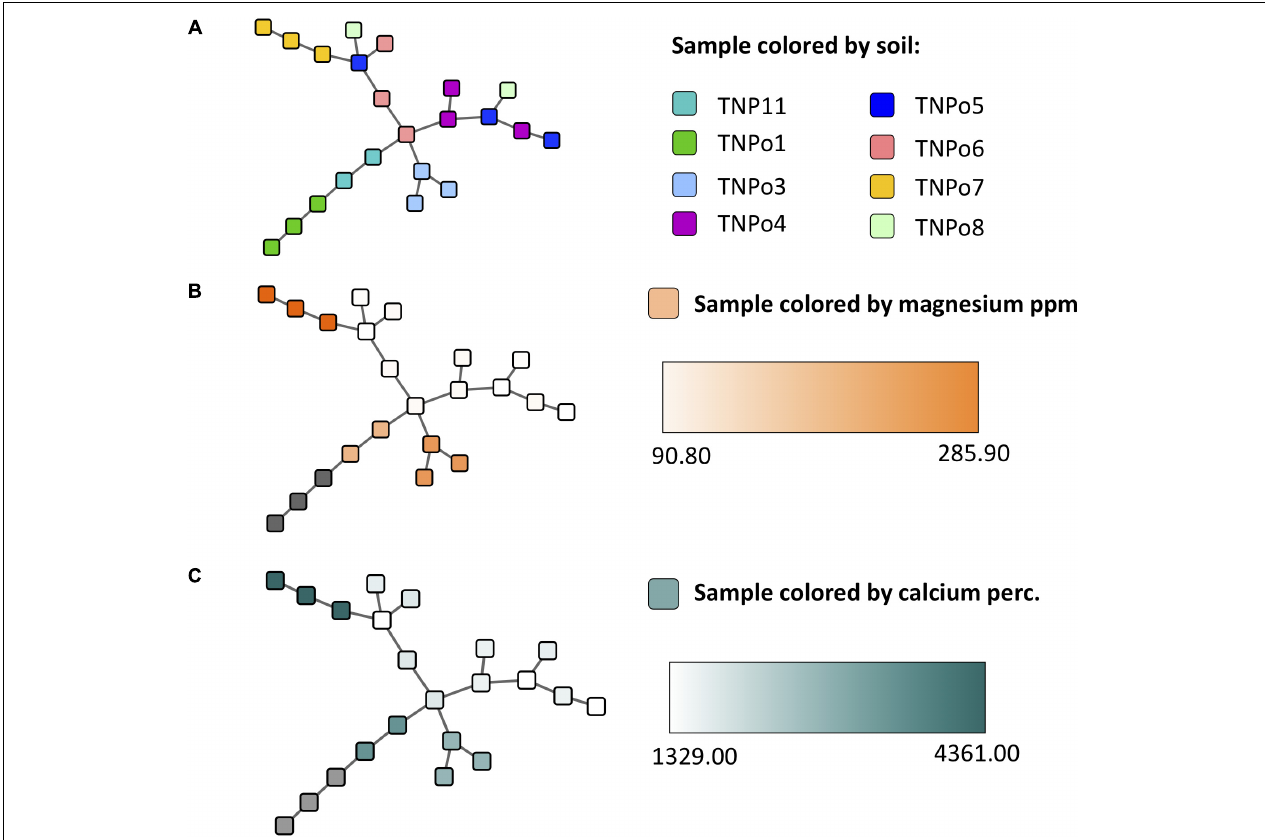
FIGURE 7 | Experiment 2 (soil origin) sample similarity MSTs (constructed using the Proportional Similarity metric) representing similarity of samples based on their operational taxonomic unit (OTU) content, colored by (A) soil, (B) magnesium ppm of soil, and (C) calcium content of